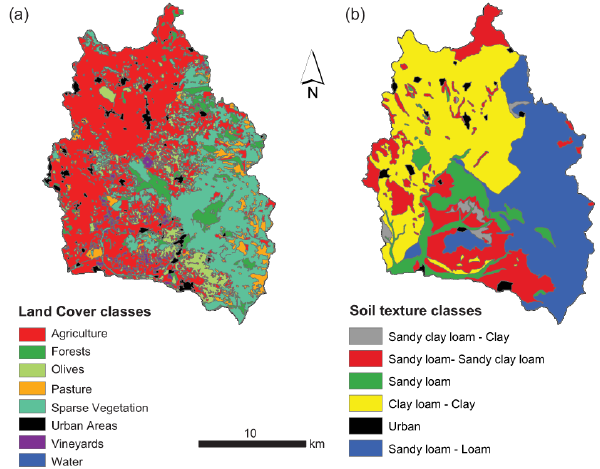
Fig. 2. (a) Land cover and (b) soil texture maps used as input for the tRIBS model.